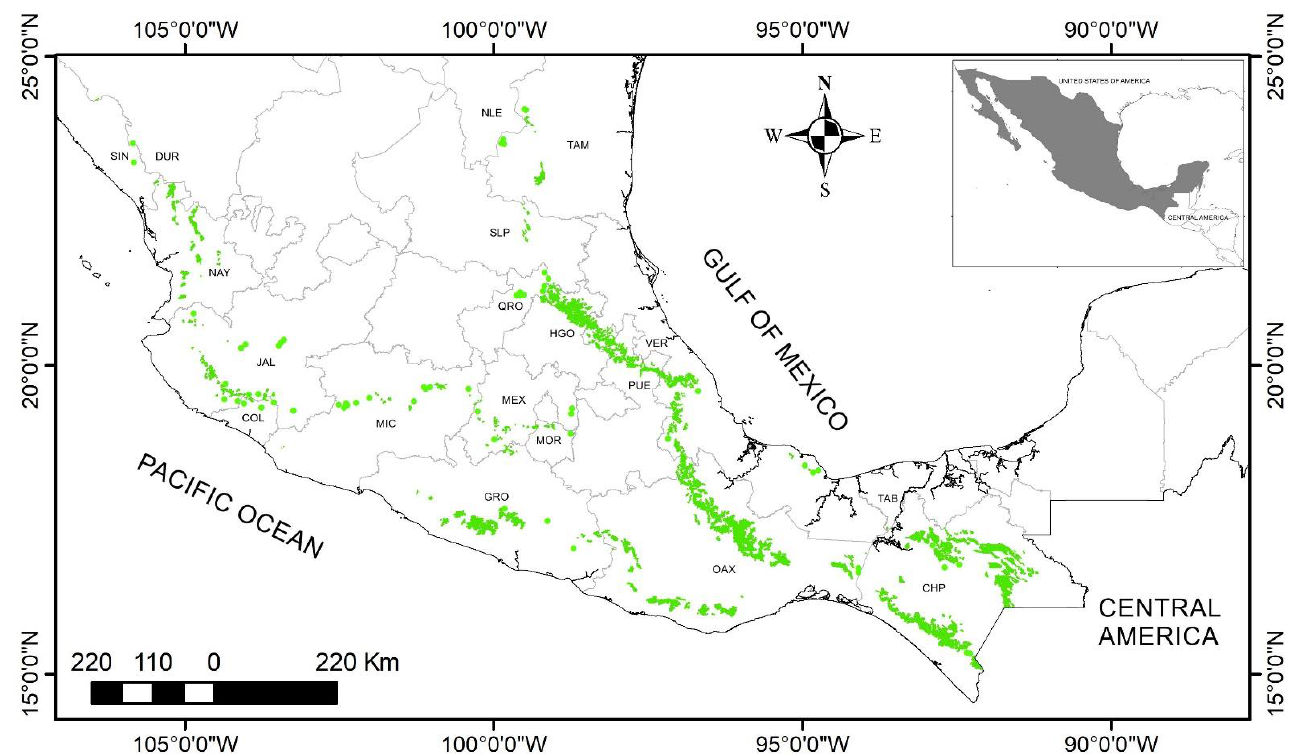
Figure 1. Map of Mexico showing the geographic location of the TMCF (modified from [11]). Mexican state abbreviations are as follows: CHP, Chiapas; COL, Colima; DUR, Durango; GRO, Guerrero; HGO, Hidalgo; JAL, Jalisco; MEX, México; MIC, Michoacán; MOR, Morelos; NAY, Nayarit; NLE, Nuevo León; OAX, Oaxaca; PUE, Puebla; QRO, Querétaro; SIN, Sinaloa; SLP, San Luis Potosí; TAB, Tabasco; TAM, Tamaulipas; and VER, Veracruz.